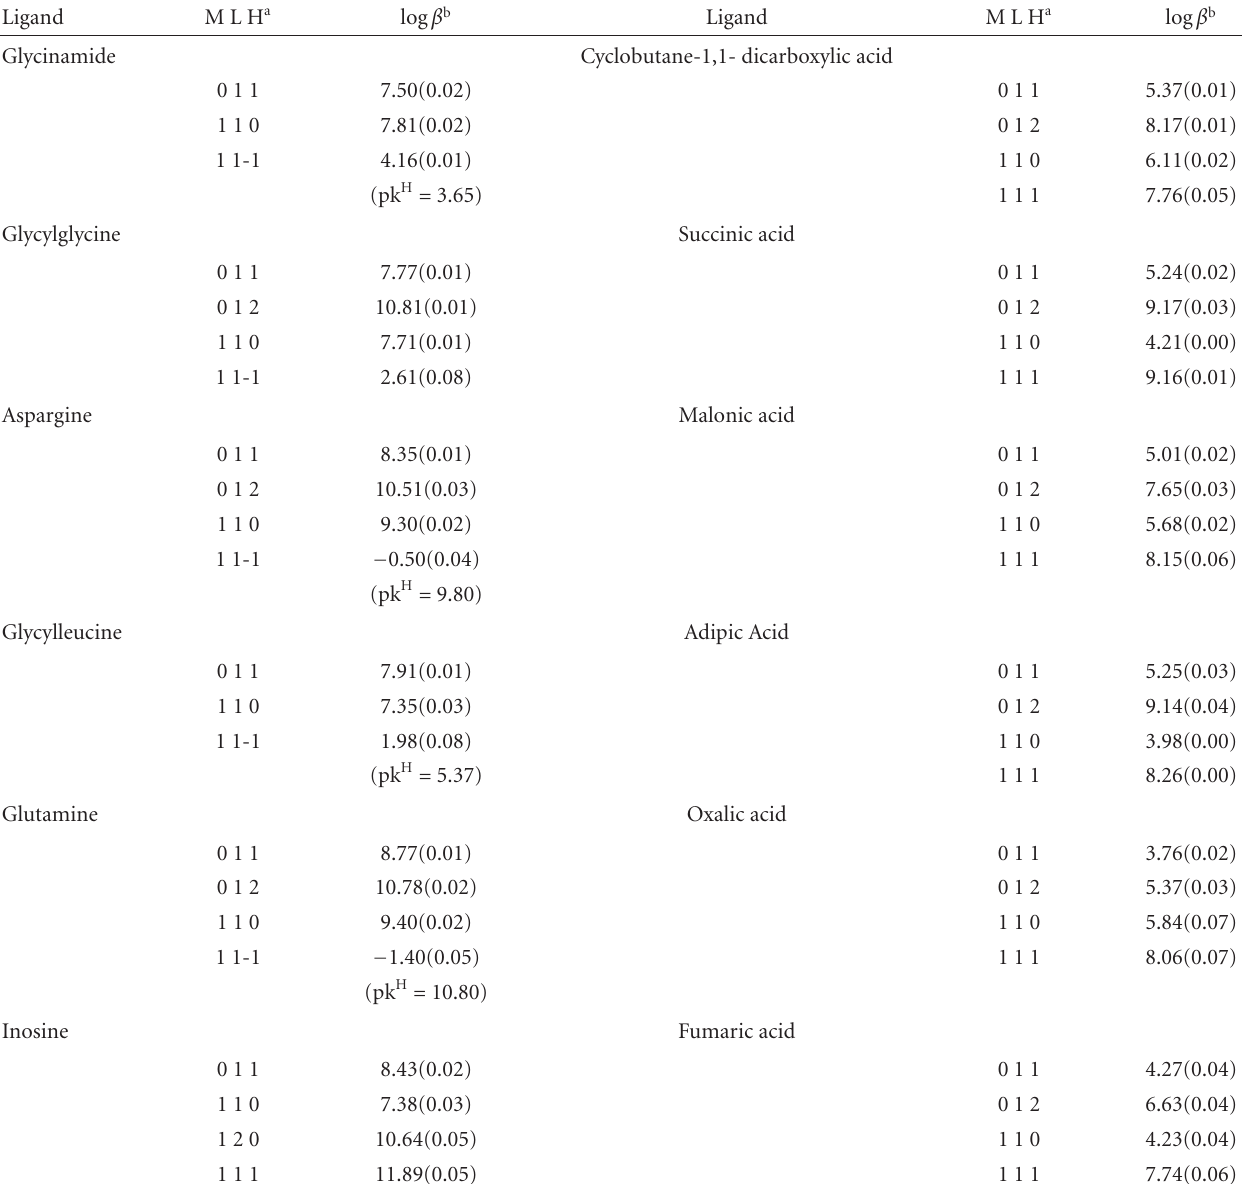
Table 2: Formation constants for complexes of [Pd(DEEN)(H 2 O) 2 ] 2+ with peptides, dibasic acids, and DNA units at 37 ◦ C and 0.16 M ionic